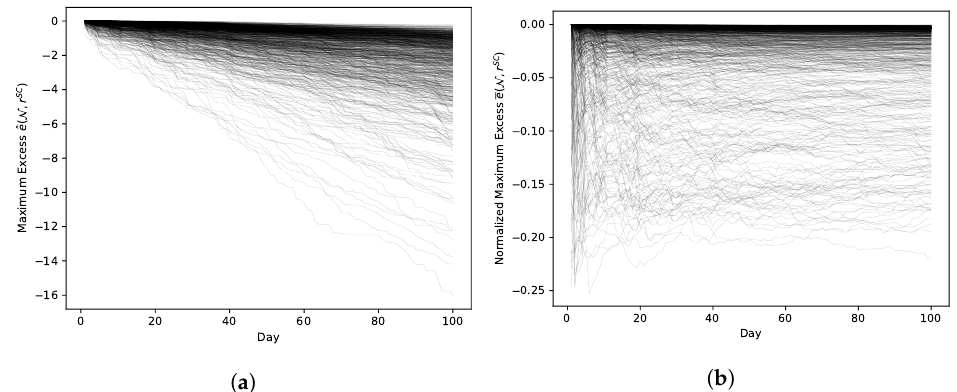
Figure 9. Progress of maximum excess ( a ) and normalized maximum excess ( b ) with Shapley–core for 1000 trials. Table 4. Number of trials with increasing, decreasing, and no trend in the excess and normalized excess between day 20 and 100 with Shapley–core benefit distribution.